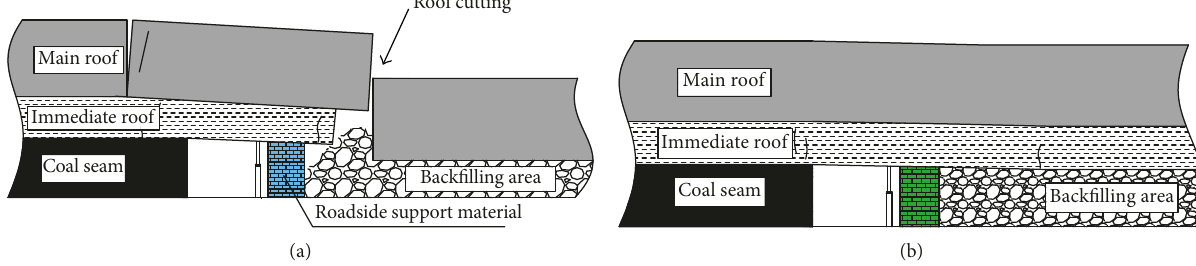
Figure 1: GER of gob roof managed by different methods. (a) GER with roof managed by caving method. (b) GER with roof managed by backfilling